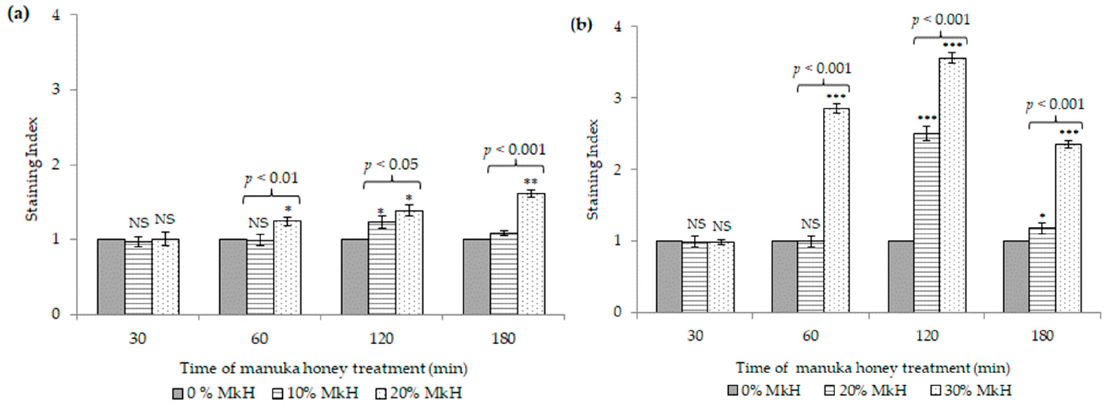
Figure 2. Effect of MkH over membrane potential of S. aureus CECT 86 ( a ) and E. coli CECT 515 ( b ), evaluated using DiBAC4 (3) staining. Data at each time point corresponds to mean ± standard deviation. NS indicate no significant differences and asterisks indicate significant differences (*: p < 0.05; **: p < 0.01; ***: p < 0.001) between treated cells vs. the control (non-treated cells). p- values, indicate significant differences ( p < 0.05) between the two honey concentrations tested.